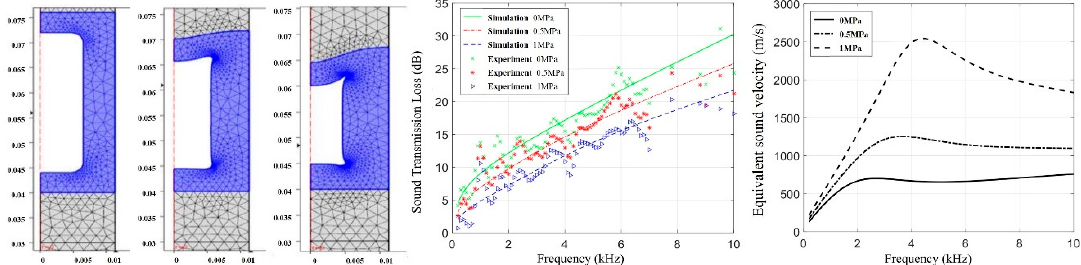
Figure 5. Acoustic properties of acoustic coatings under hydrostatic pressure. Deformed shape of the unit cell, transmission loss, and the equivalent sound velocity of the sound insulation layer under different static pressure [26].